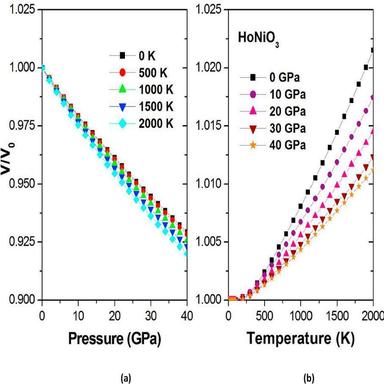
The V=V0 rate as a function of the pressure (temperature) at different given temperatures (pressures).